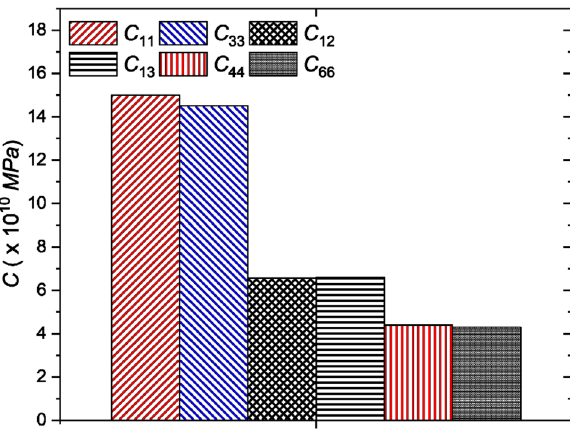
Figure 2. Elastic properties of the BCZT